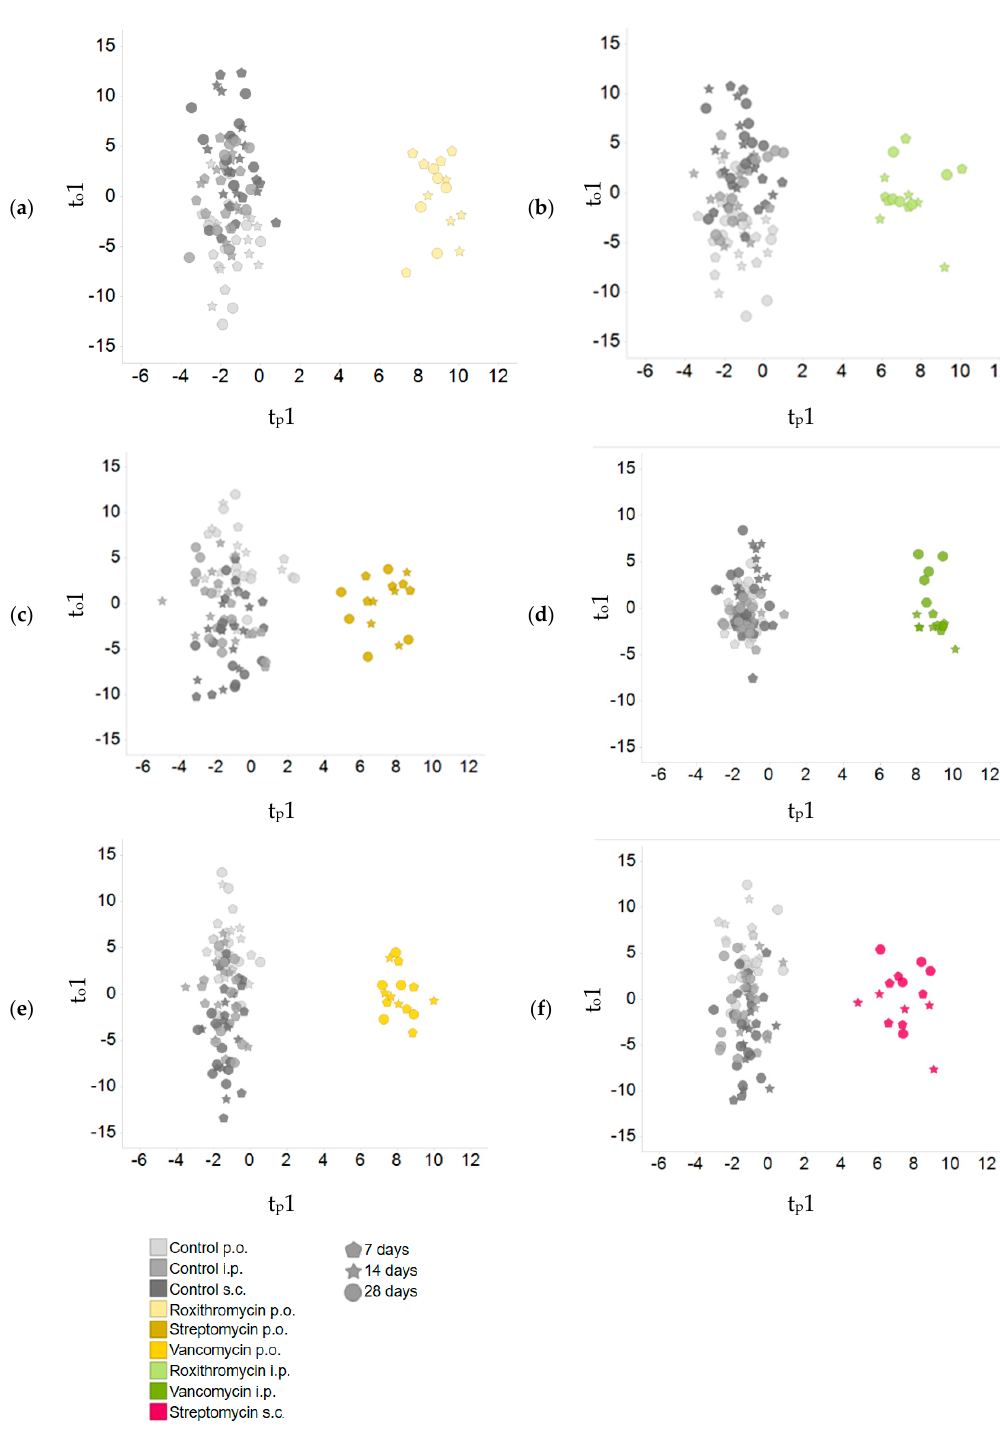
Figure 2. O-PLS-DA score plots. Individual models were generated by comparing samples from each antibiotic treatment and application route to all controls. ( a ) roxithromycin p.o. ( b ) roxithromycin i.p. ( c ) streptomycin p.o. ( d ) vancomycin i.p. ( e ) vancomycin p.o. ( f ) streptomycin i.p. Rats were either orally or parenterally dosed with vancomycin, streptomycin and roxithromycin ( n = 5 per group). The control group received no treatment, the gavage control group received 0.5% CMC in drinking water and the intraperitoneal and subcutaneous control group were injected with a saline solution ( n = 10 per group). Each dot represents a single plasma sample. The di ff erent days are represented by di ff erent point shapes. t p 1, scores for first predictive component; t o 1, scores for first orthogonal component; p.o., per os (by mouth); i.p., intraperitoneal; s.c.,